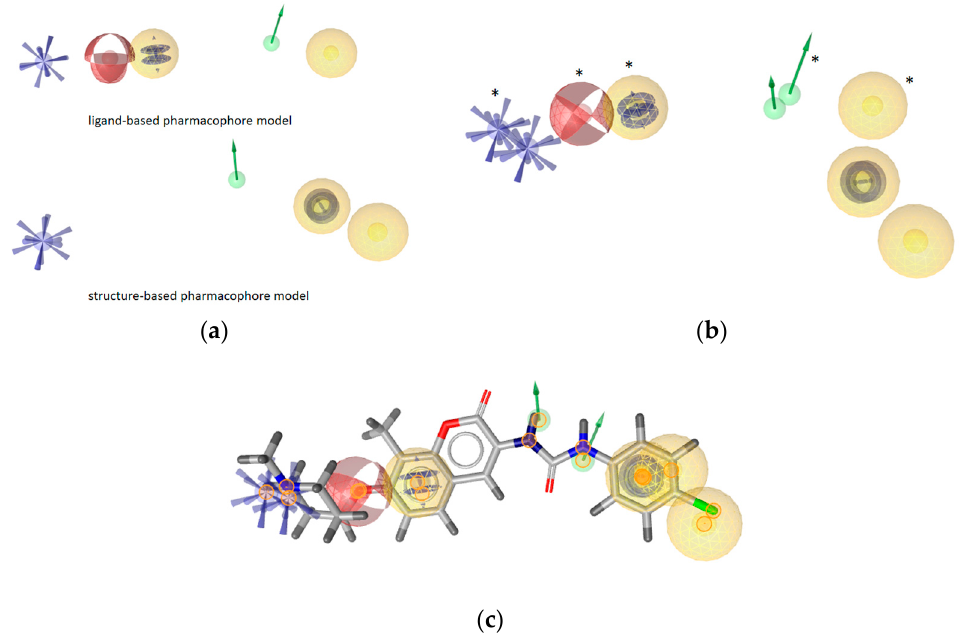
Comparison of the ligand and molecular dynamics(MD)-derived structure-based pharmacophore models prioritized for virtual screening to identify Hsp90 CTD inhibitors. ( a ) Ligand-based (LB) model (above) and structure-based (SB) model below. Exclusion volumes not displayed. ( b ) The LB and MD-SB derived models aligned. Features marked by * belong to the LB model. ( c ) Alignments of both models and compound 2 . The pharmacophore features are as follows: hydrophobic (yellow spheres), aromatic (blue disc), hydrogen bond donor (green arrow), positive ionizable (blue